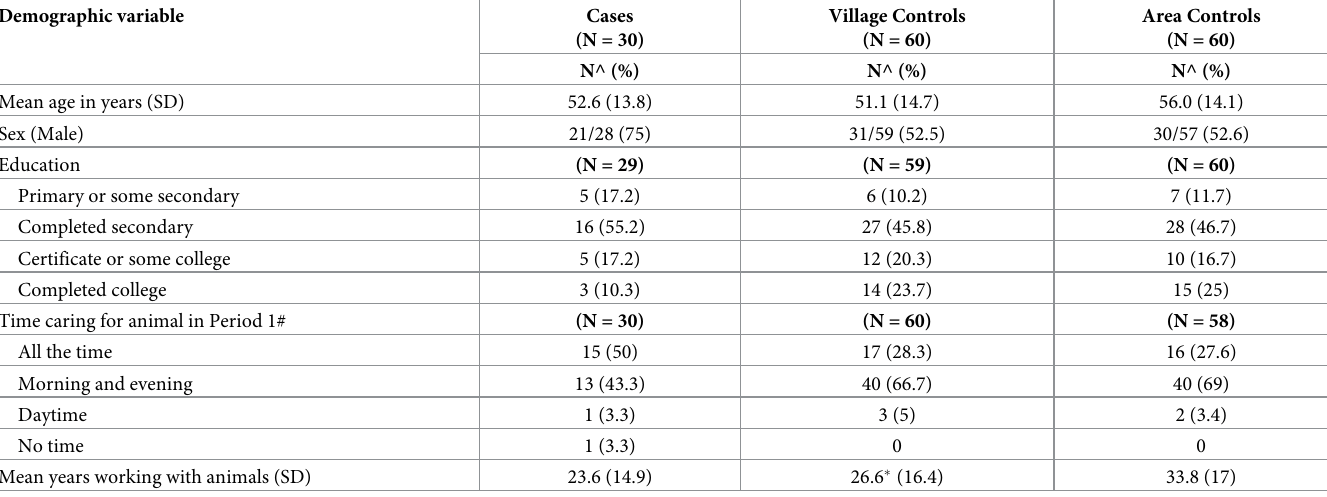
Table 1. Demographics of handlers of cattle with anthrax (‘Cases’) and handlers of matched uninfected cattle (‘Controls’) in Georgia, June 2013–May 2015. Demographic